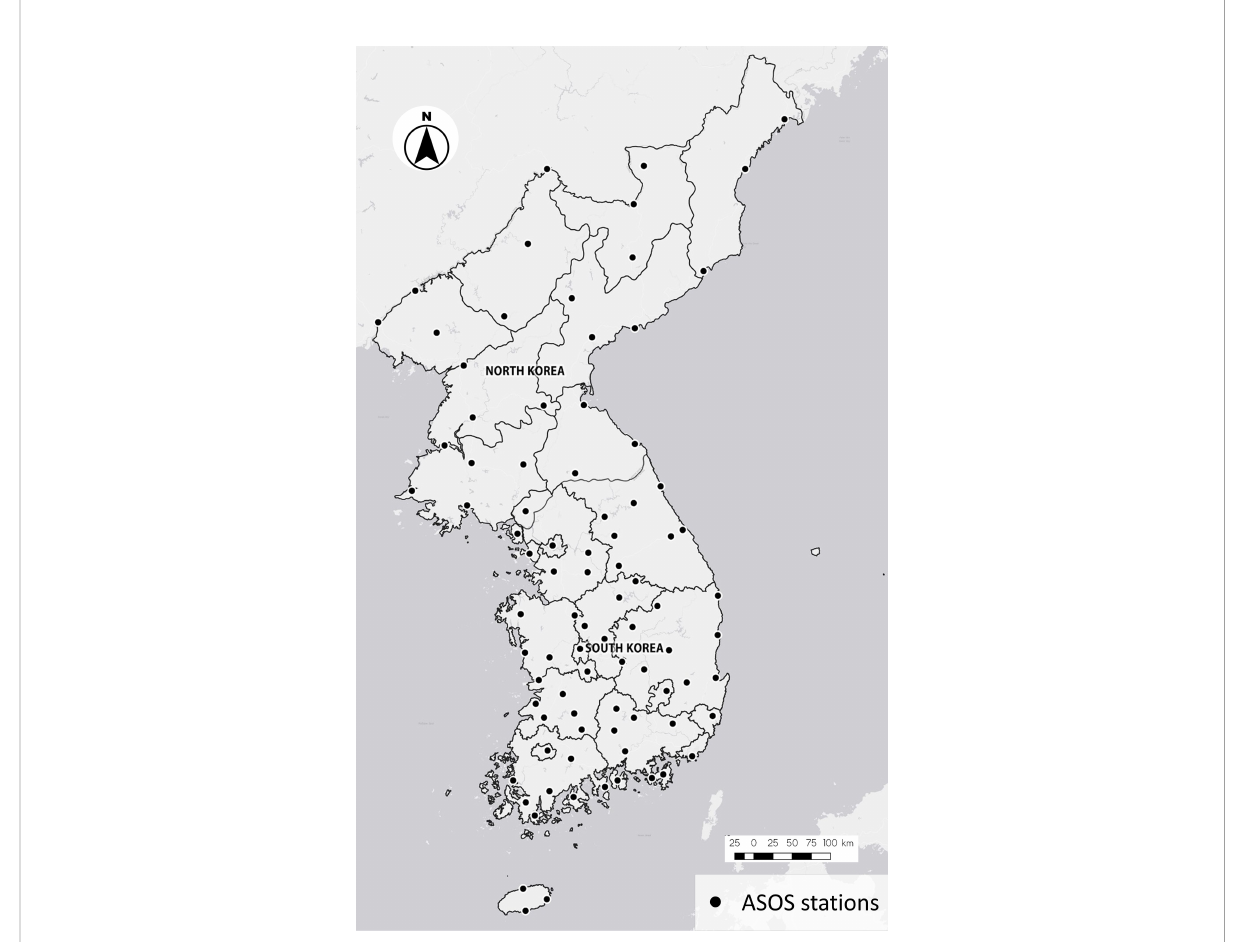
FIGURE 1 The Korean Peninsula with the location information of the 87 Automatic Synoptic Observation System (ASOS) stations used in the